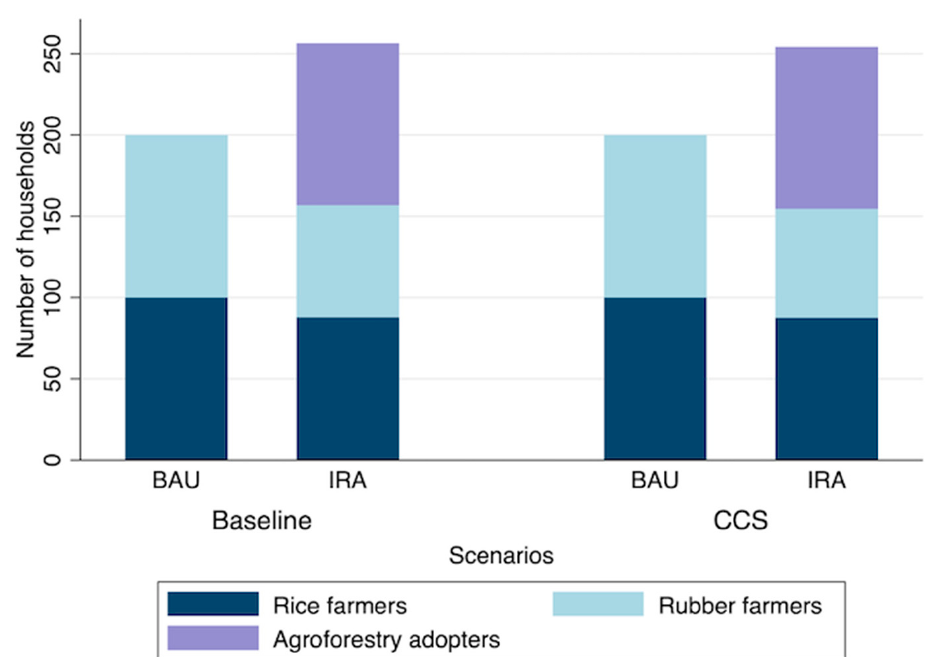
Figure A4. Simulation results: farmers’ livelihood choices in the baseline and climate change sce- nario.